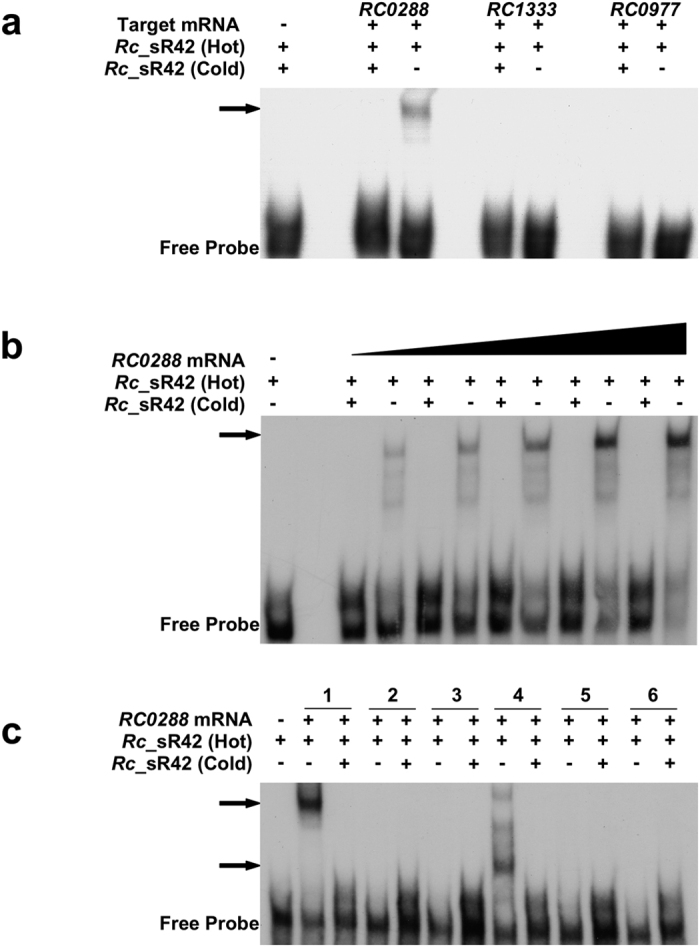
EMSAs showing the interaction of Rc_sR42 with cydA target mRNA.In vitro transcripts of Rc_sR42 and target mRNAs were generated from PCR templates amplified from R. conorii genomic DNA using primers containing T7 promoter (Supplementary table S2). Only the full length Rc_sR42 transcript was labeled with [α-32P] UTP. For cold competition, unlabeled full length Rc_sR42 was used. The samples were separated on native 4% polyacrylamide gels, vacuum dried, and developed by autoradiography. The photomicrographs shown are a representative gel from three independent experiments. (a) EMSA showing the interaction of R. conorii Rc_sR42 with RC0288 (cydA) target mRNA in vitro. The arrow indicates gel-shifted Rc_sR42-cydA mRNA complex. The other target mRNAs (RC0977 and RC1333) did not show any interaction. (b) EMSA showing the interaction of R. conorii Rc_sR42 with increasing concentrations of RC0288 (cydA) target mRNA in vitro. An increase in the complex intensity was observed with increasing concentrations of RC0288 mRNA. (c) EMSA showing the identification of seed region of Rc_sR42 and cydA interaction. Different regions of cydA mRNA fragment (see Supplementary Fig. S9) were used for incubation with full length Rc_sR42 to identify the seed region. The genomic locations for in vitro transcribed fragments of cydA are as follows: 1: 293225–293587 (363 bases); 2: 293284–293587 (304 bases); 3: 293311–293587 (277 bases); 4: 293225–293464 (240 bases); 5: 293284–293464 (181 bases); and 6: 293311–293430 (120 bases). A gel shifted complex (indicated by arrow) was observed only in 1 and 4 indicating that the seed region in cydA mRNA is located between bases 293225–293283 corresponding to R. conorii genome (PATRIC genome ID: 27944.4).